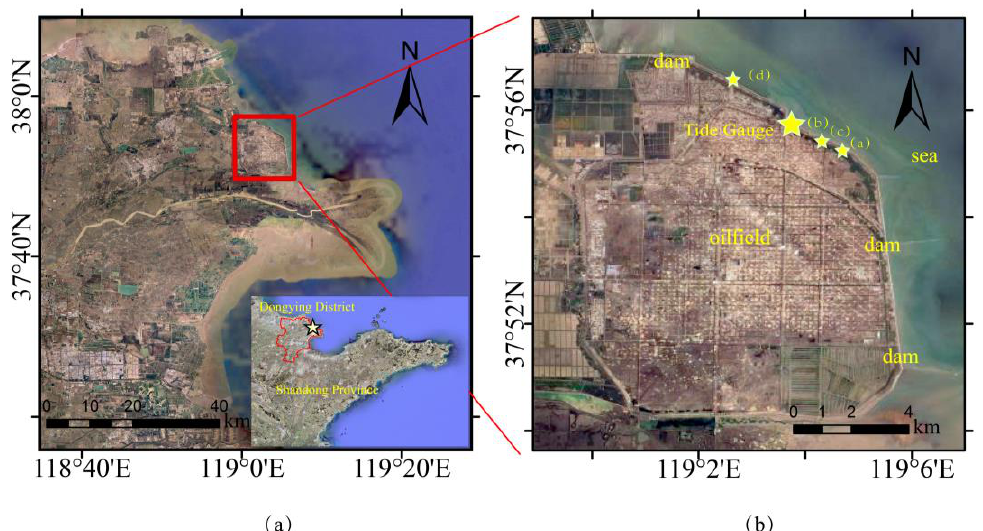
Figure 1. Location of Gudong Dam taken from Google Earth: ( a ) general location of the Gudong Oilfield in the Yellow River Delta. The red polyline and yellow pentagram in the lower right subgraph show the Dongying District and location of the Gudong Oilfield, respectively; ( b ) detailed image of the Gudong Oilfield. Large pentagram indicates the location of tide gauge, whereas small ones show the aerial photo sites in Figure 3.